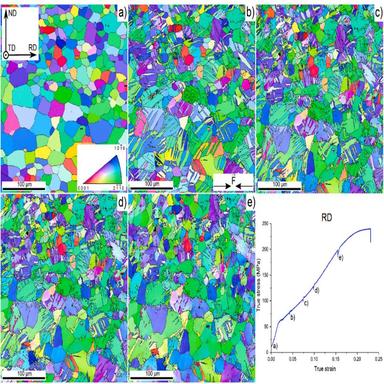
Microstructural evolution of the RD sample during compression represented by orientation maps corresponding to several points of interest on the deformation curve. Compression was applied in the horizontal direction.